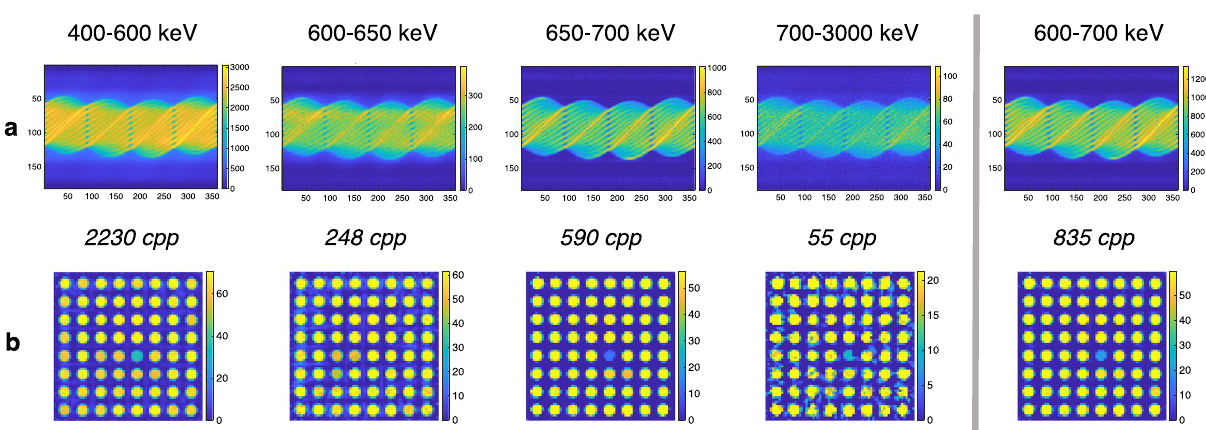
Figure 5. Sinograms ( a ) and reconstructed gamma activity images ( b ) from different gamma energy windows for the same 8 × 8 − 1 assembly as in Fig. 4a (BU 18.6 GWd/tU, CT 37 a). Average counts per sinogram pixel in each energy window are listed underneath the